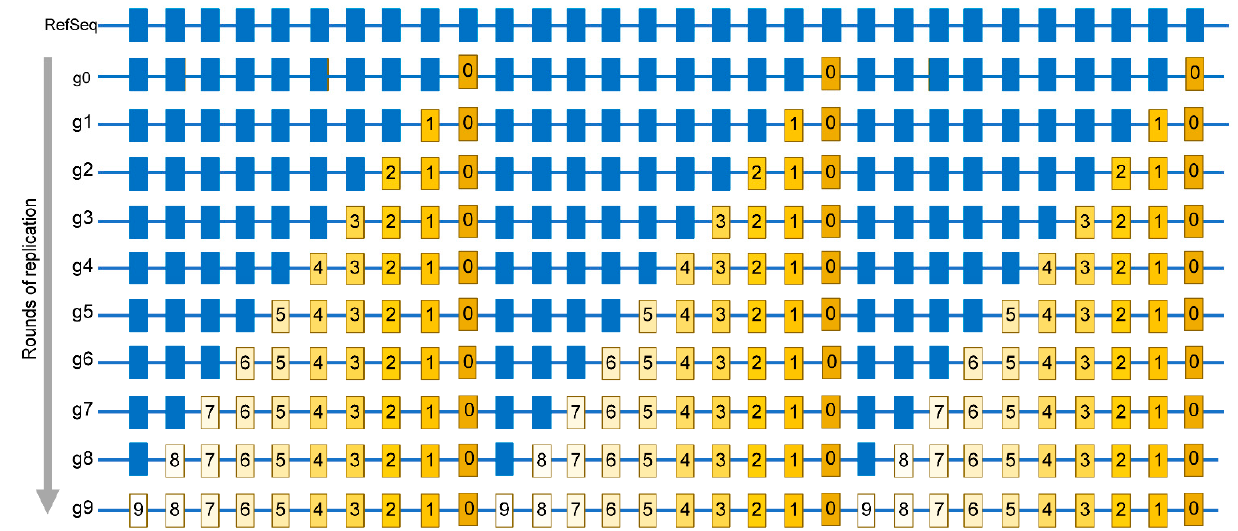
Figure 4. Simplified schematic of mutations accumulation in virus population. Mutations are identified by comparing a sequence of a viral isolate with a reference sequence (RefSeq). Individual positions where bases are mutated in at least one isolate are shown by rectangles. Blue rectangles are positions same as in RefSeq. g0—A genome of virus quasispecies starting a population that may already have some differences from RefSeq. g1—g9 rounds of replication generating additional mutations, which are numbered same as the generation in which a mutation event had occurred. Mutations occurring in later generations would be present in smaller fractions (reflected by the decreasing yellow color density) within the population. The entire set of independent mutation events would be described by the list in which every mutation is represented only once, regardless of the number of genomes where it is found. In this population, such a list is represented by the g9 genome.